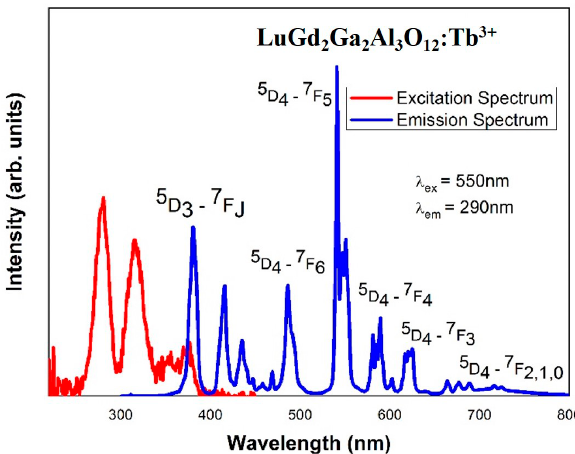
Figure 4. Excitation and Emission spectra of LuGd 2 Ga 2 Al 3 O 12 :Tb 3+ phosphor by UV light.